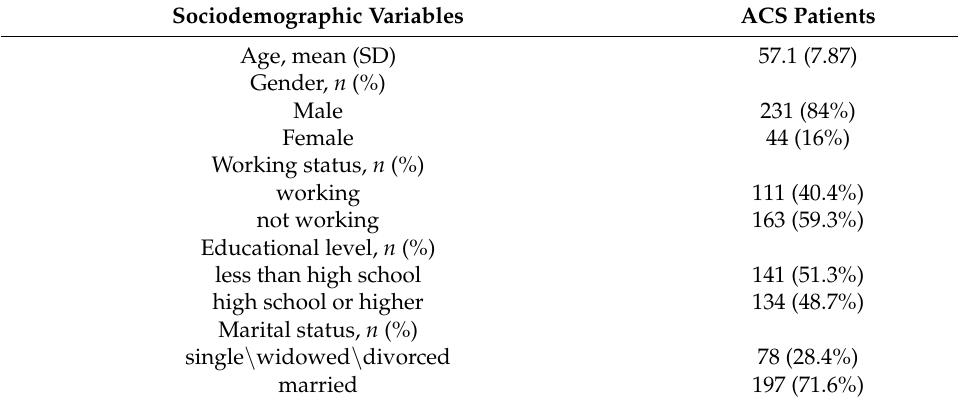
Table 1. Sociodemographic characteristics of the sample ( N = 275). Means and standard deviations (SD) are reported for age. Frequencies ( n ) and percentages are reported for gender, working status, educational level, and marital status.